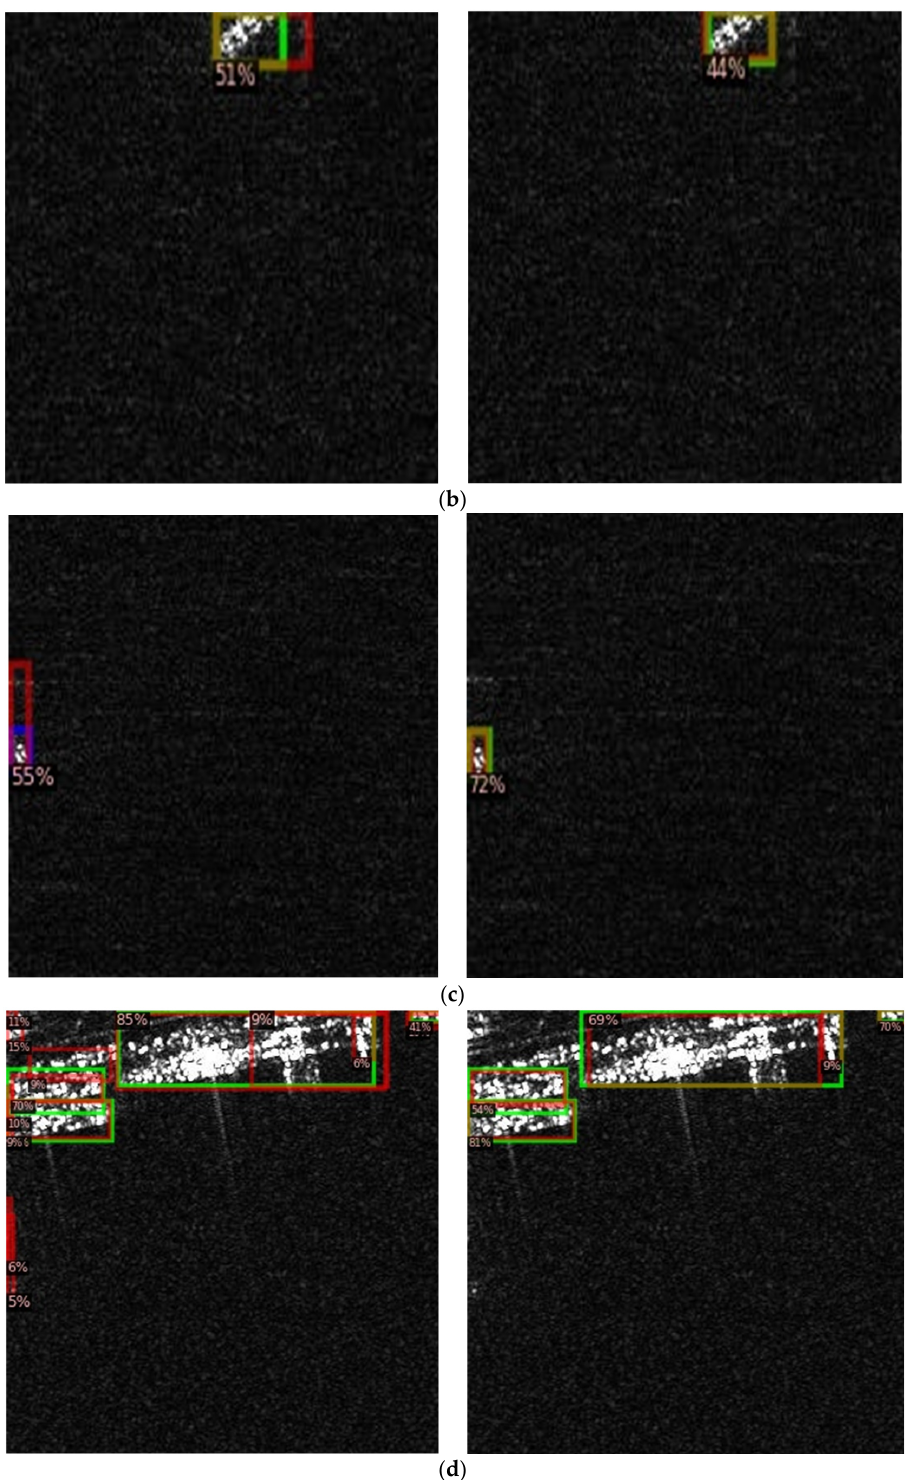
Figure 18. Enlarged comparison images of some typical targets in Figures 16 and 17 between traditional random cropping algorithm (left column in each panel) and the proposed method (right column in each panel). The green boxes represent the true bounding boxes of the targets that were successfully detected. The blue boxes indicate the true bounding boxes of the targets that were not successfully detected. The red boxes represent the model prediction results, and the number on the red box represents the model’s confidence in this prediction result. ( a ) Example 9; ( b ) Example 10; ( c ) Example 11; ( d ) Example